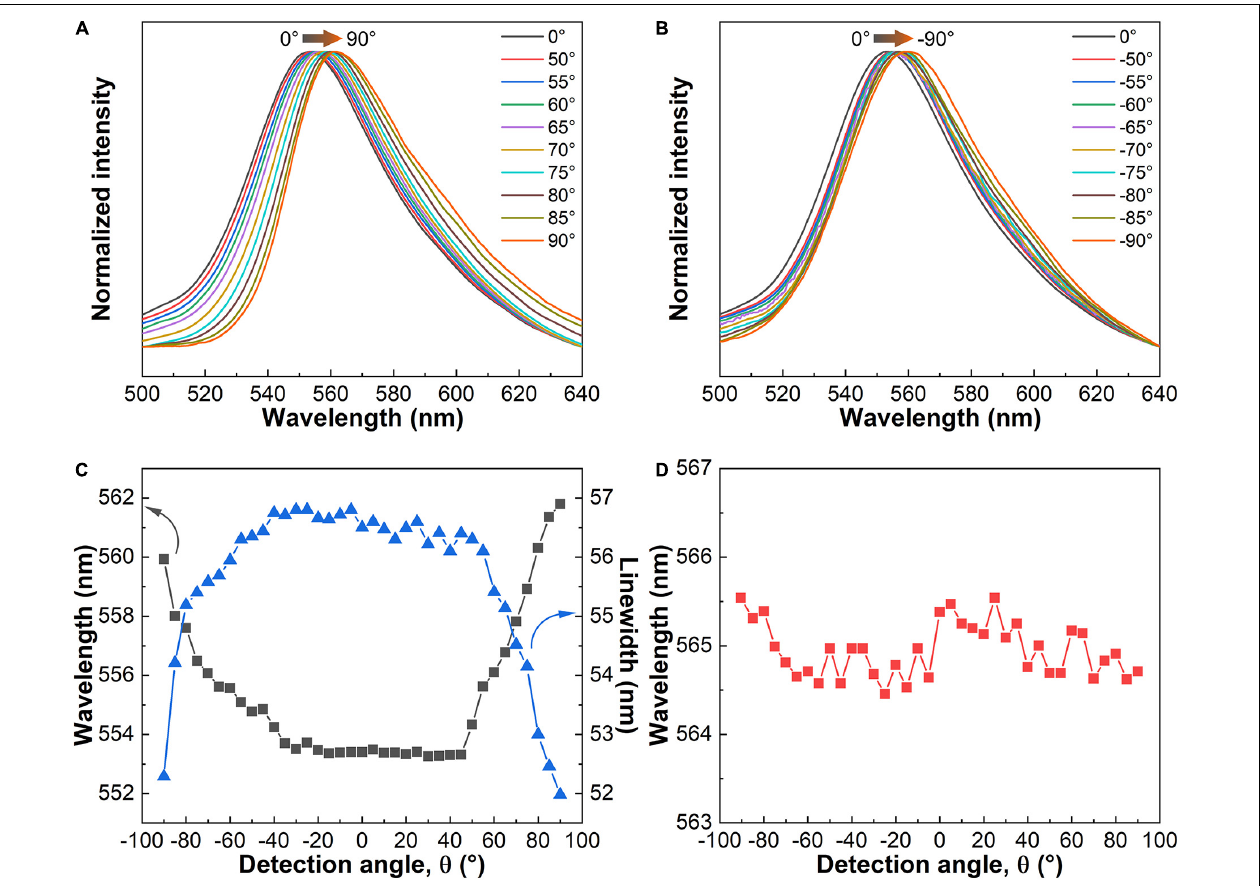
FIGURE 6 | Angle-dependent emission spectra of CS4-Rh under excitation at 348 nm: − 90 ◦ < θ < 0 ◦ (A) and 0 ◦ < θ < 90 ◦ (B) . Variation of the maximum wavelength ( λ 0 ) and linewidth of the emission bands of the CS4-Rh composite as a function of the detection angle (C) . Variation of λ 0 of the emission bands of an Rh6G-containing cellulose membrane as a function of the detection angle (D)